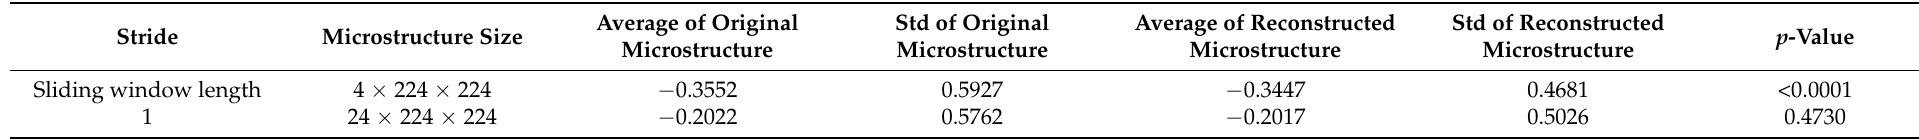
Table 7. Evaluation of reconstructed microstructures from 3-layer 3D CAEs trained with calendered and uncalendered mini